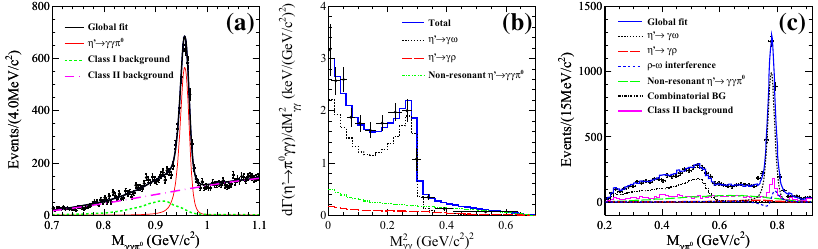
Figure 4. (a) Results of the fit to M γγπ 0 for the selected inclusive η (cid:3) → γγπ 0 signal events; (b) partial for the inclusive η (cid:3) → γγπ 0 decay; (c)distribution of the invariant mass M γπ 0 width (in keV) versus M 2 γγ and fit results in the η (cid:3) mass